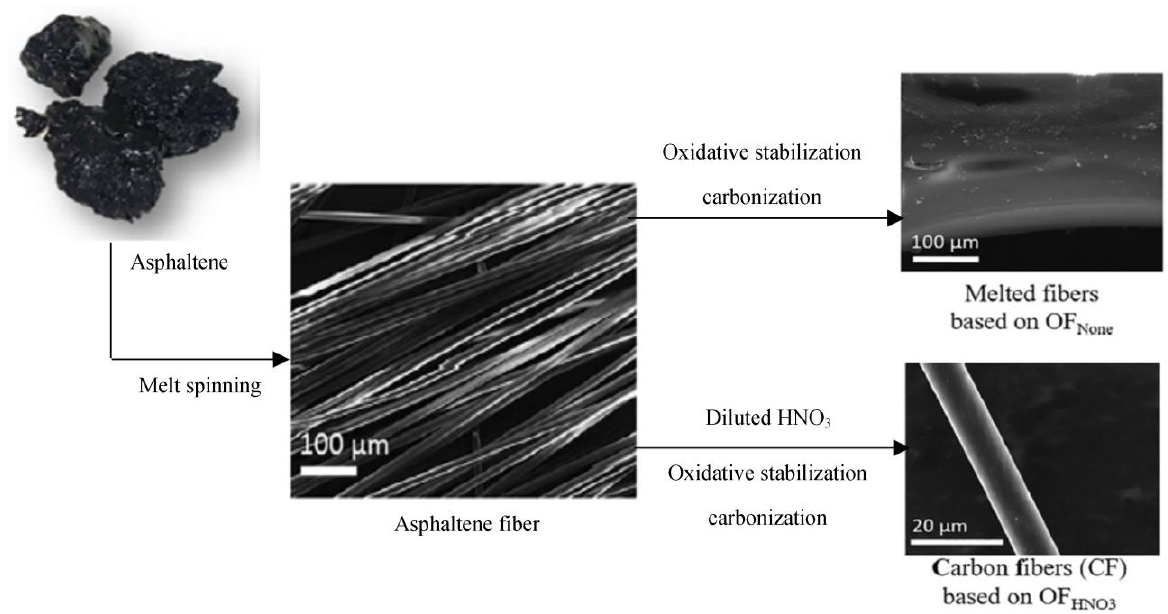
Figure 21. Asphaltene-based carbon fiber manufacturing process (reprinted with permission from Ref. [78]).